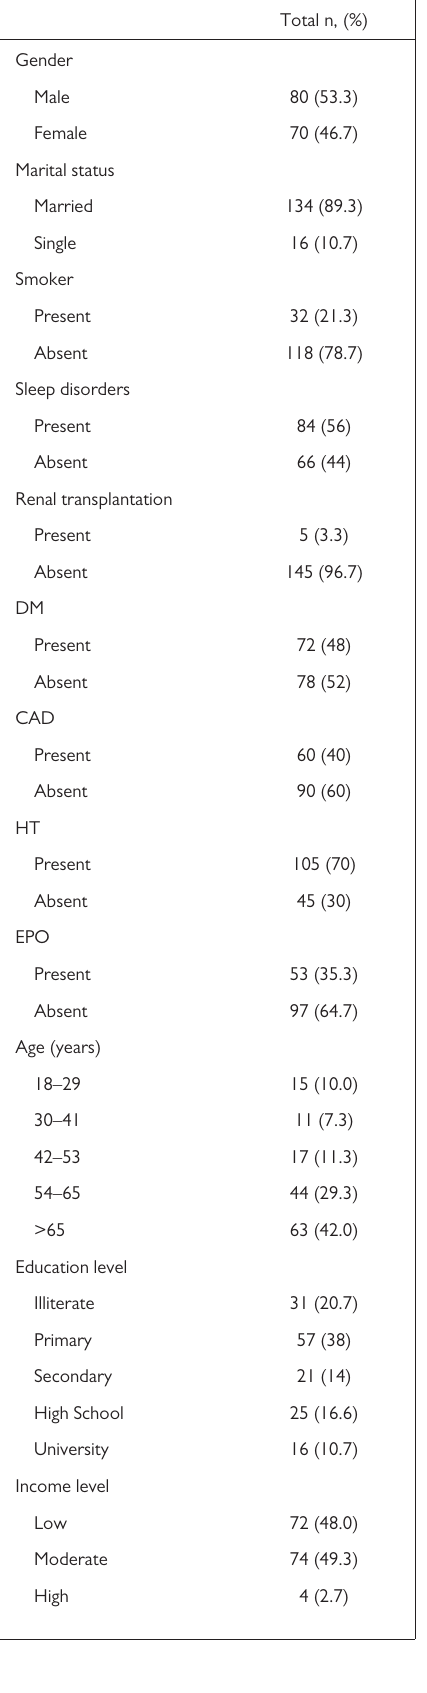
Table 1. Patients ’ Sociodemographic and Clinical Characteristics